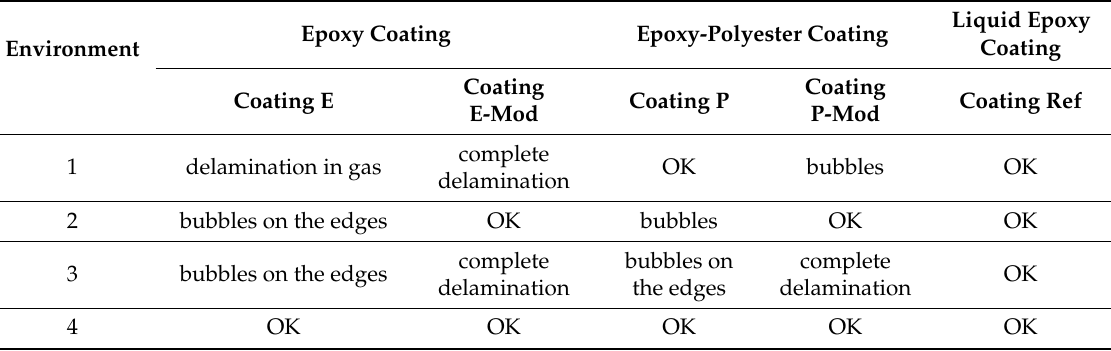
Table 3. Pack test